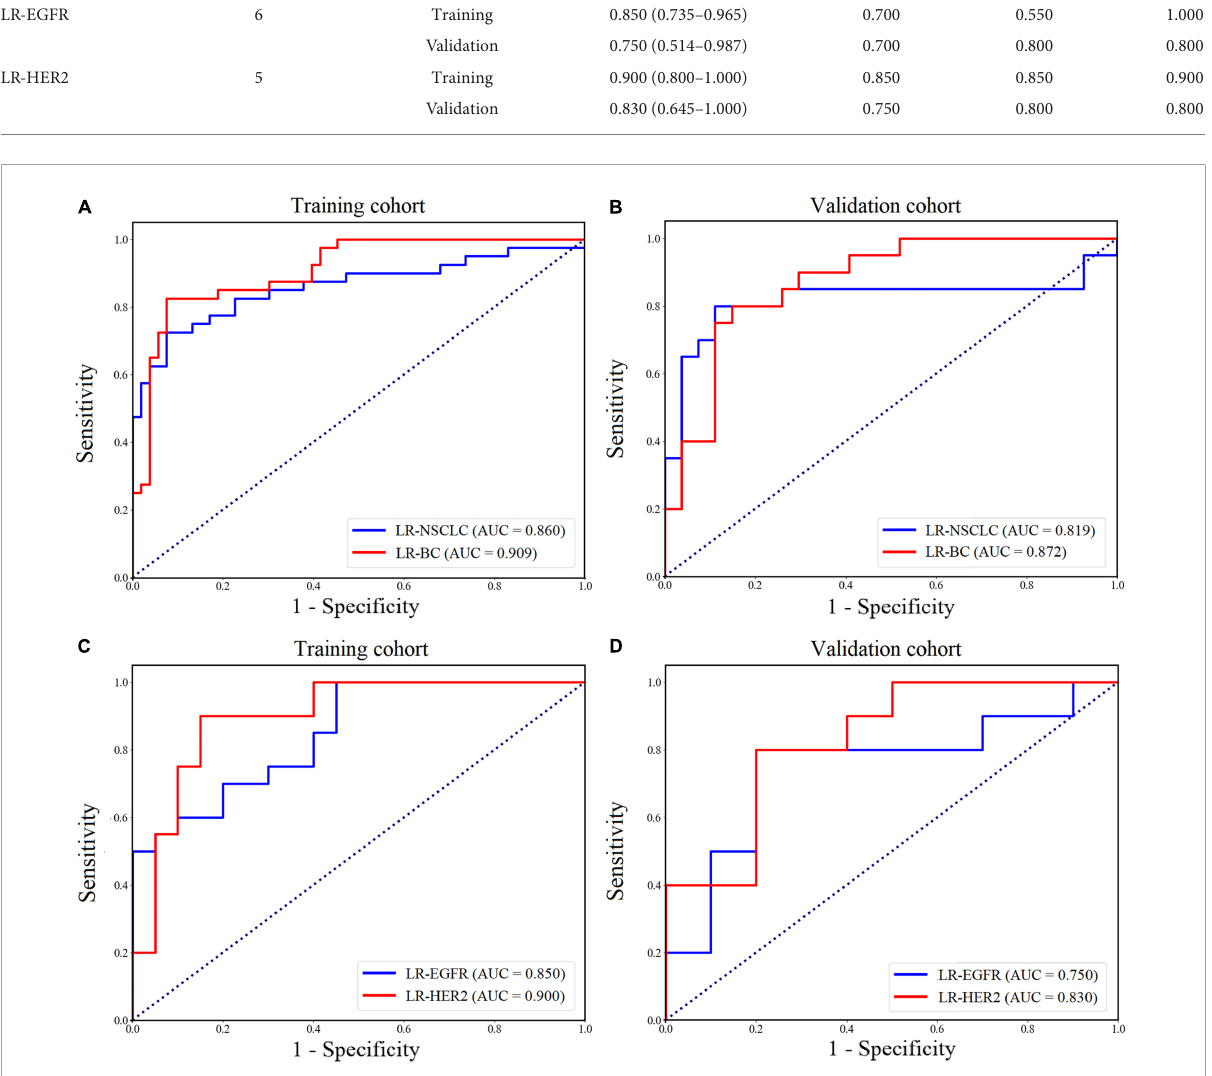
FIGURE5 Receiver operating characteristic (ROC) curves of the models for predicting metastatic origins (A,B) in the training (A) and validation (B) cohort, and for predicting the EGFR mutation and HER2 status (C,D) in the training (C) and validation (D) cohort.